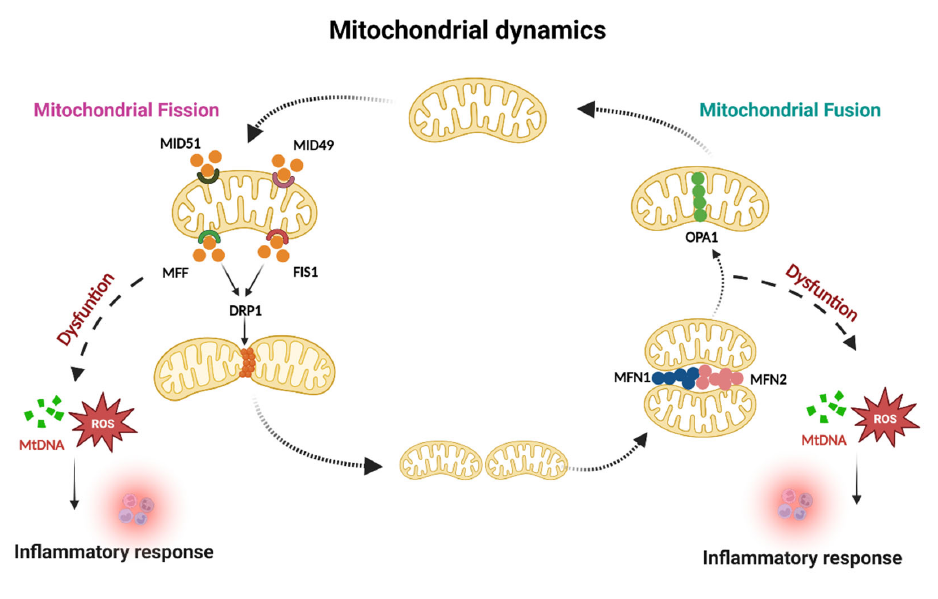
Figure 1. Mitochondrial dynamics and inflammation.